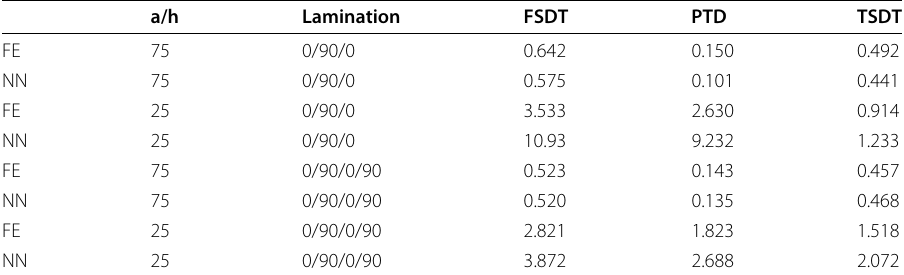
Table15 Influence of a/h and lamination on some particular cases from Figs. 17 and 18